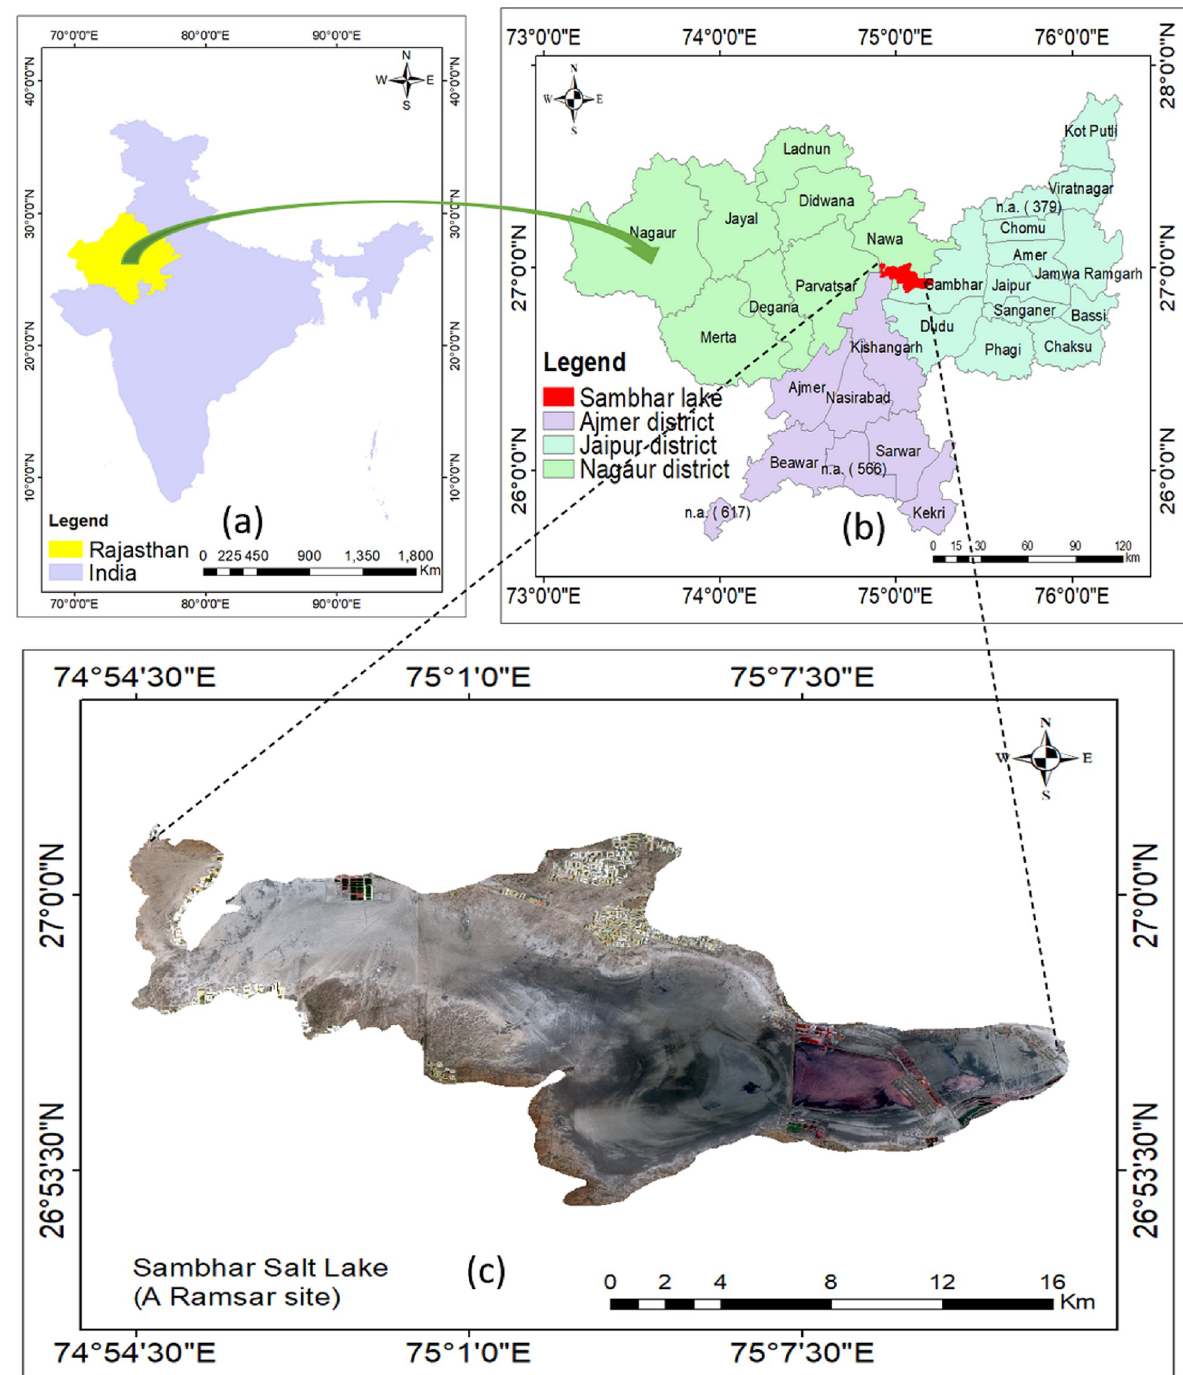
Fig 1. Study area. (a) India with Rajasthan state highlighted in yellow colour (b) SSL amid Nagaur, Jaipur and Ajmer districts (c) True Colour Composite of SSL prepared using Sentinel data set of 7 May 2021.